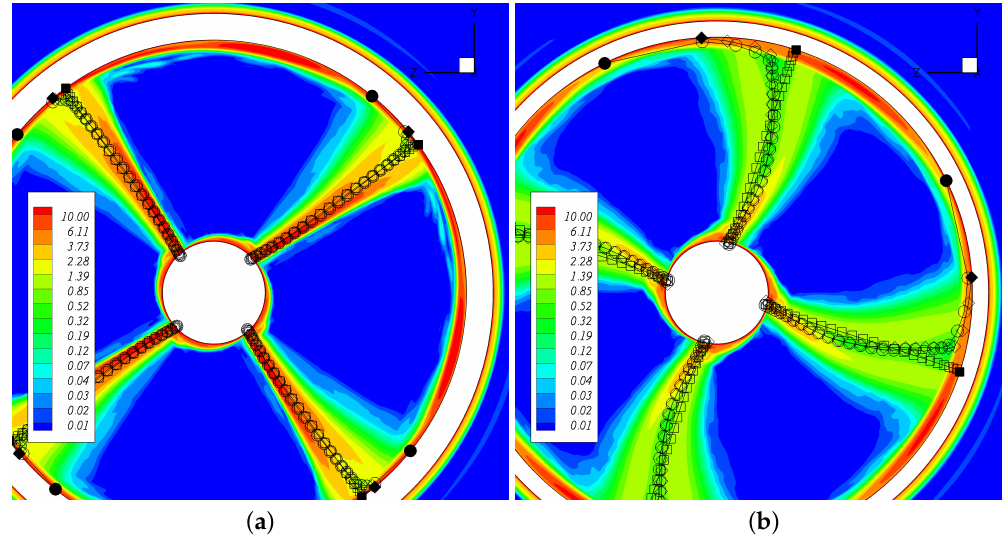
Figure 12. Wake geometry at x / R = 0.2 ( a ) and x / R = 0.4 ( b ) for J = 0.5. The contours represent the ReFRESCO total vorticity field | (cid:126) ω | / Ω . The symbols represent the PROPAN wake geometry: rigid wake model (squares), wake alignment model (diamonds) and wake alignment model with reduced gap pitch (circles). The filled symbols refer to the tip vortex.